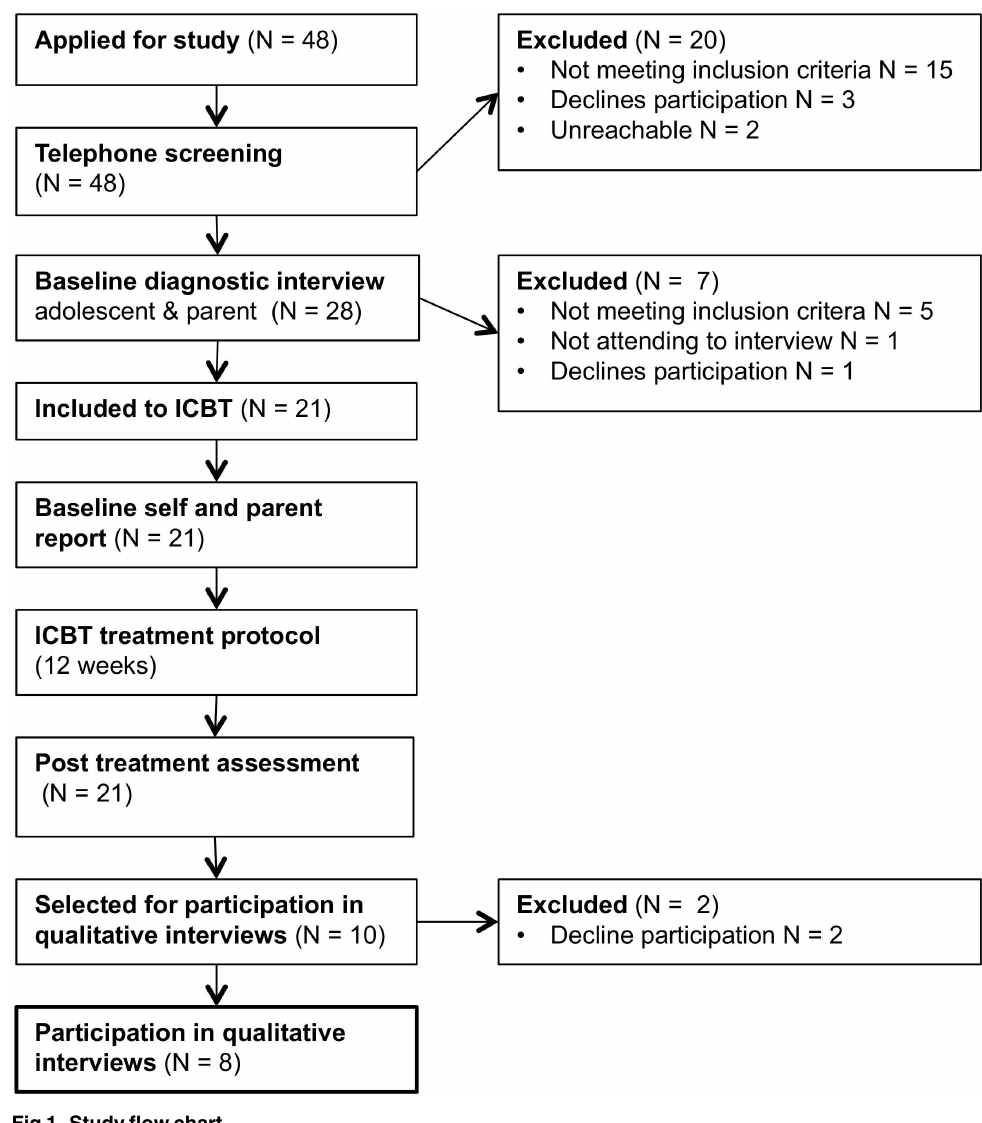
Fig 1. Study flow